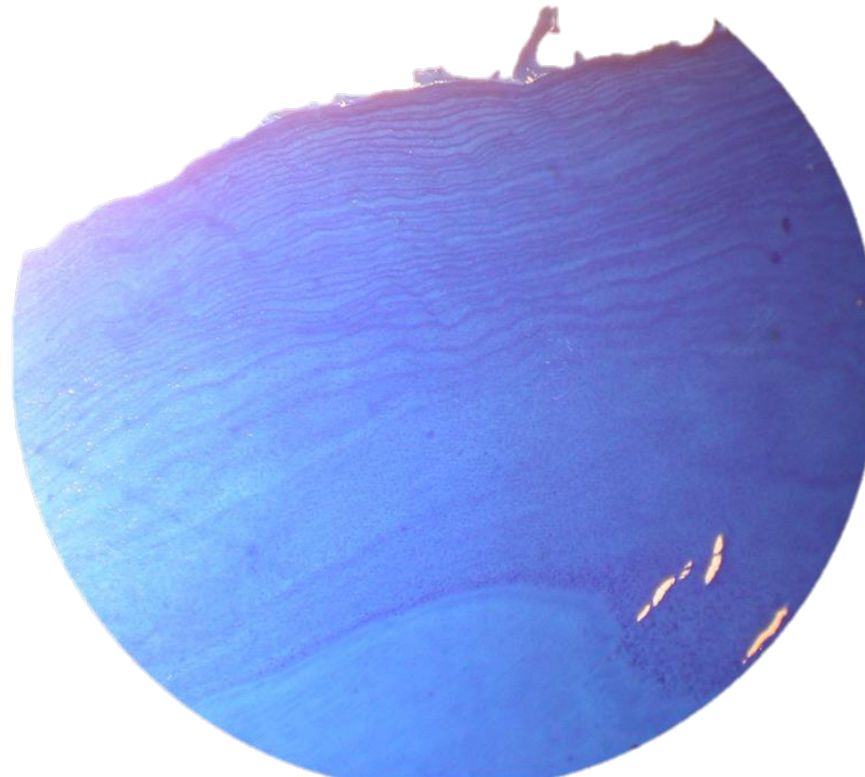
Fig. 1. Polar bear ( Ursus maritimus ) cementum in an animal aged 34 years, showing the compactness of later-forming